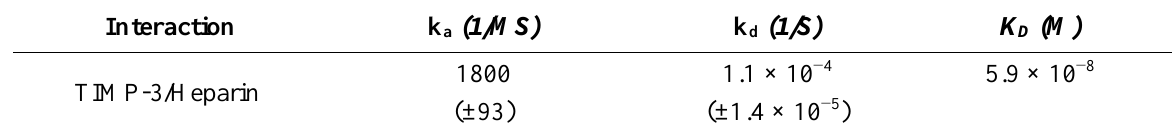
Table 1. Summary of kinetic data of TIMP-3/heparin interactions *